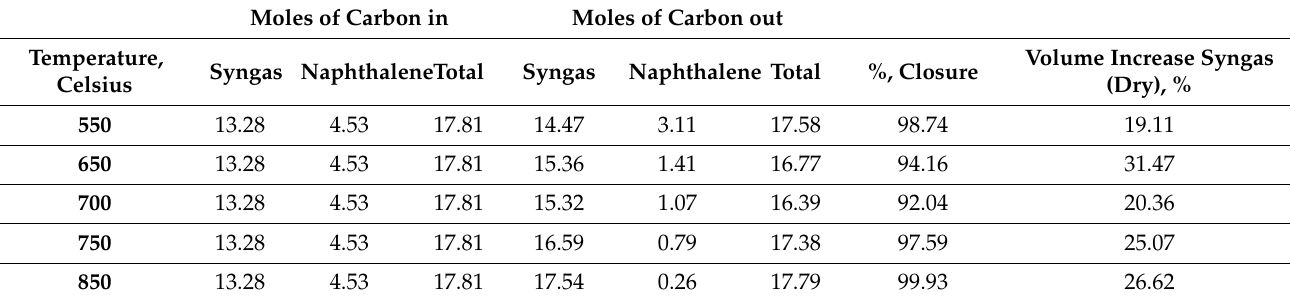
Table 3. Carbon balance: influence of temperature on naphthalene conversion (S/C—5.0, GHSV—12,800 h − 1 , catalyst—7.5% Ni-montmorillonite, naphthalene loading—58 g/Nm 3 ).